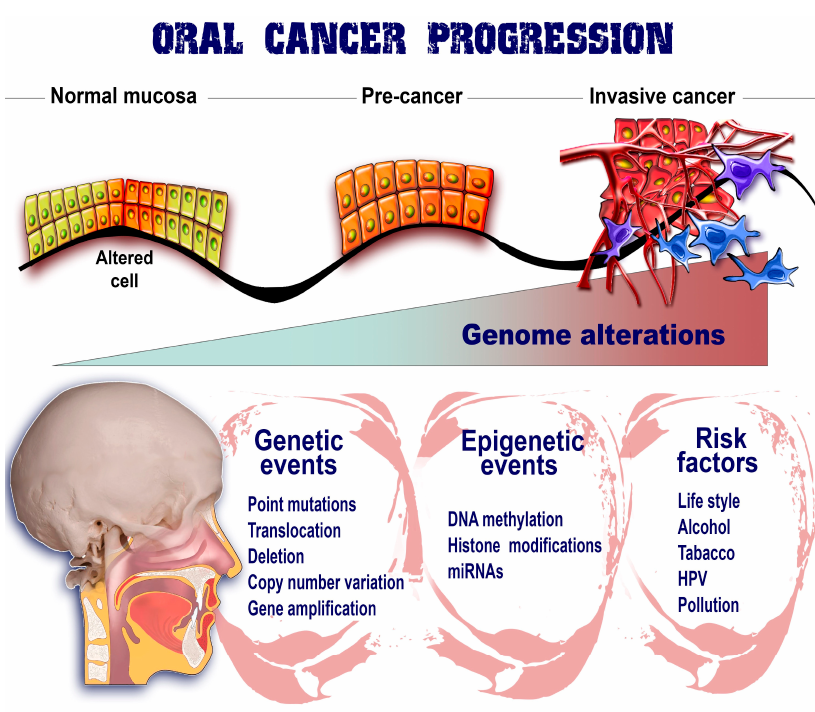
Figure 2. Epigenetic marks upon oral cancer. The evolution of oral cancer from a few altered cells to invasive phenotypes able to metastasize and populate secondary sites is the consequence of numerous factors that are interplaying their roles. Therefore, genetic events together with risk factors are combined with epigenetic mechanisms in order to ensure the proper environment for malignant development. All these factors gradually contribute to the organization of an unstable genome and also implicitly to the promotion of cancer advancement.